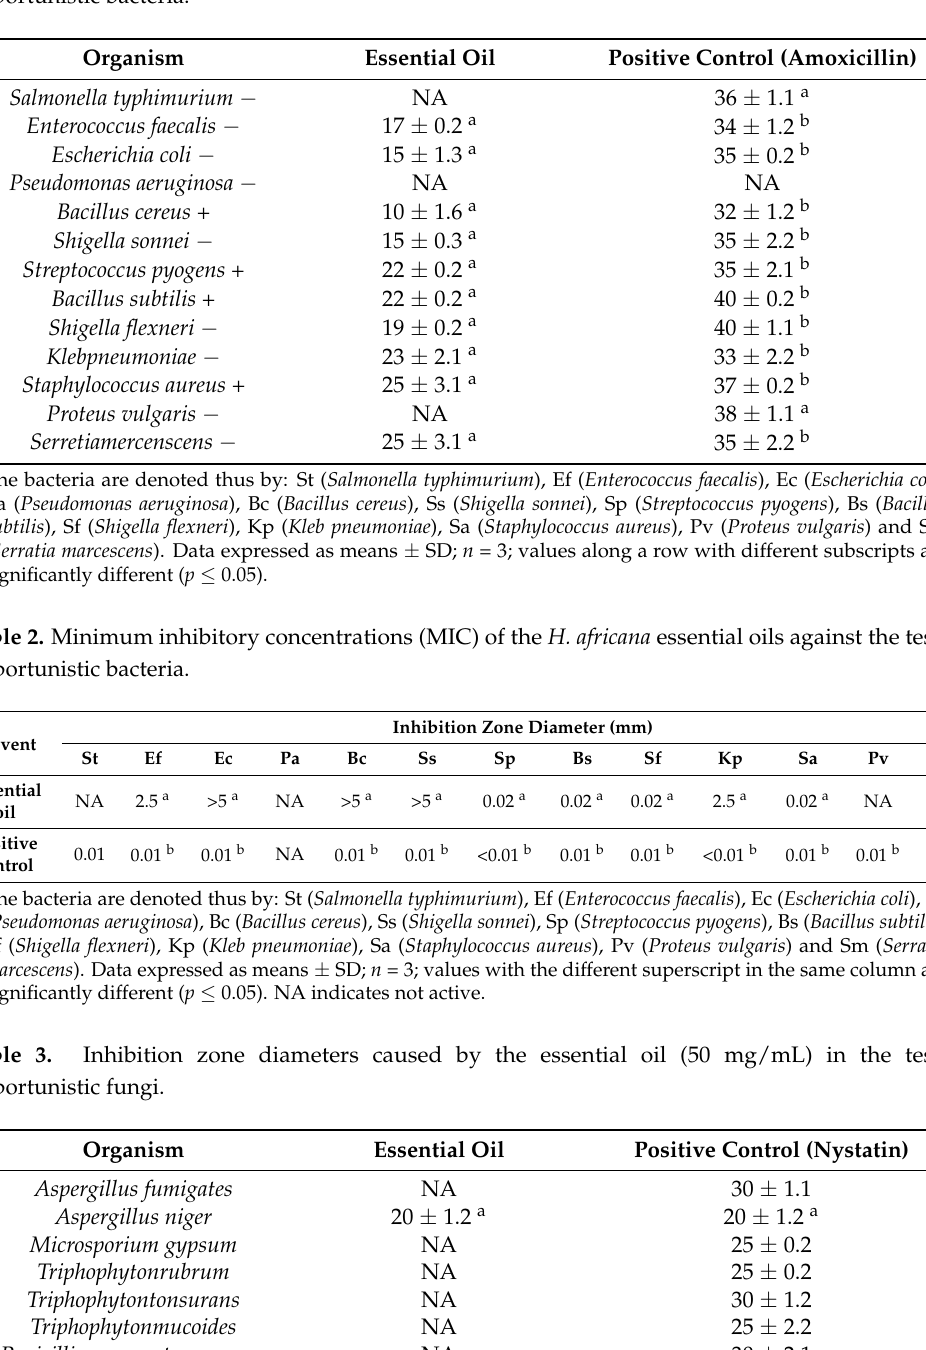
Table 1. Inhibition zone diameters caused by the essential oil (50 mg/mL) in the tested opportunistic bacteria.